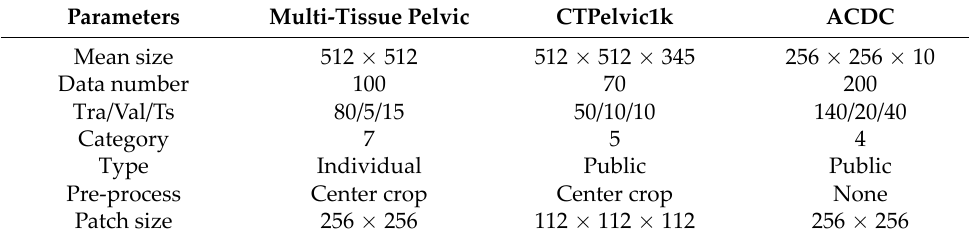
Table 1. Dataset statistics of CTPelvic1k, Multi‑tissue Pelvic, and